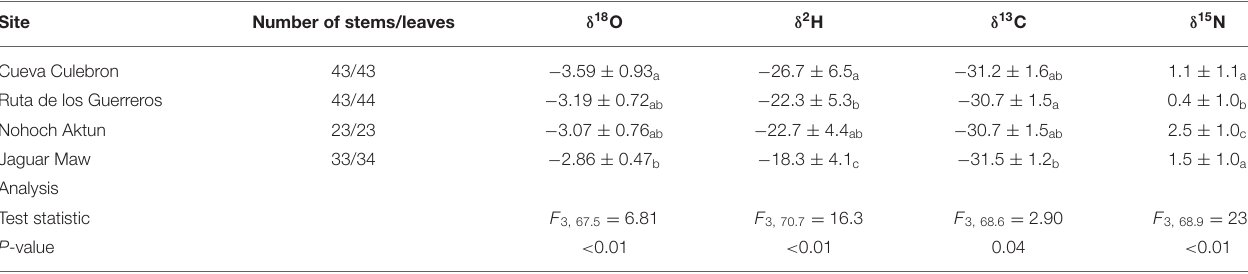
TABLE 1 | Mean and standard deviation (1 σ ) of δ 18 O, δ 2 H, δ 13 C, and δ 15 N at each study sites.